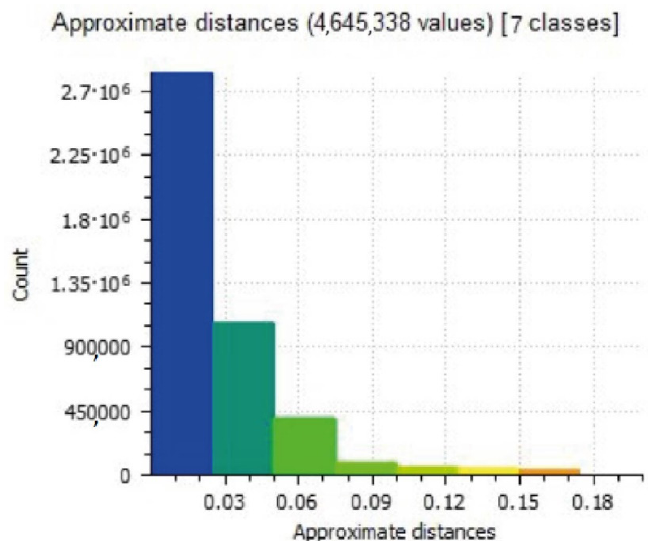
Figure 12. Distribution of distances between points of UAV-DP images and horizontal time-lapse images. The textured model with drone images is very scenic, but the resolution is lower than the model obtained with horizontal images, in particular close to the water level, shown in Figures 13 and 14.